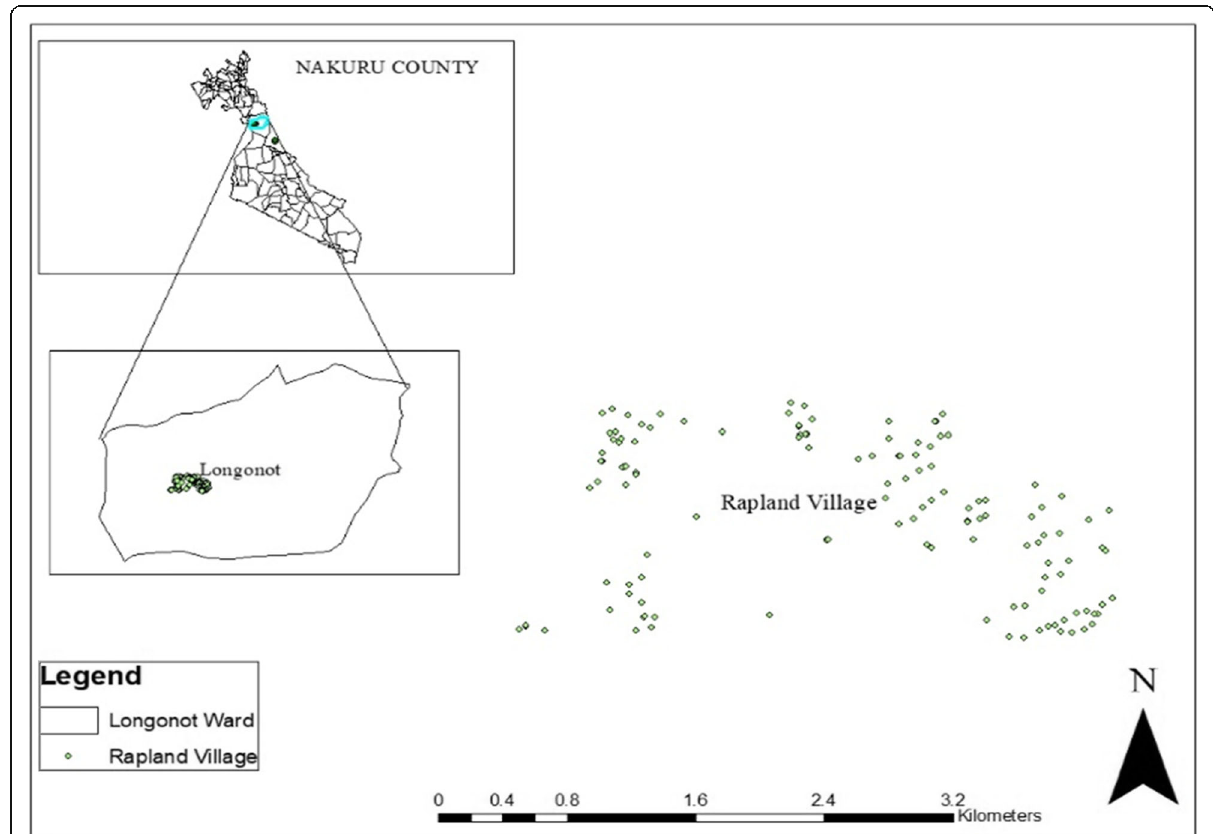
Fig. 1 Map of RAPland village. Source: area coordinates obtained during data